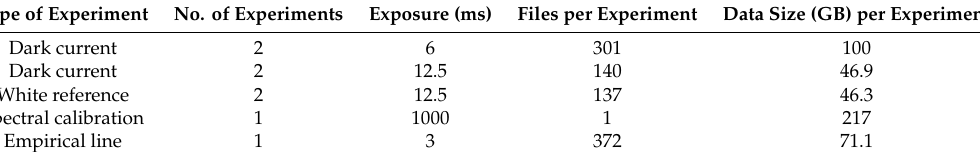
Table 1. Details of the Nano-Hyperspec data collected for each of the experiments.